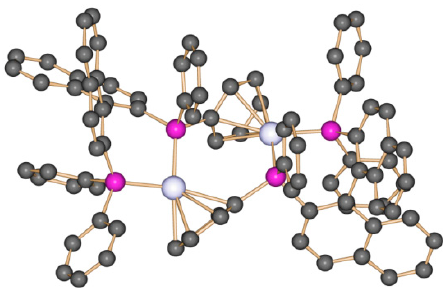
Figure 15. Molecular structure of [Rh(( R )-Binap)] 22+ . Hydrogen atoms are omitted for clarity.